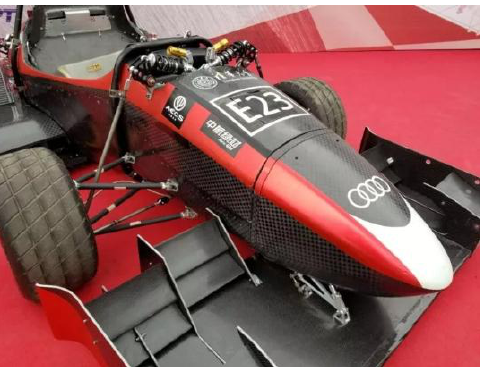
Figure 6. Electric race car, its body was manufactured using AGMP3600/honeycomb sandwich composites.